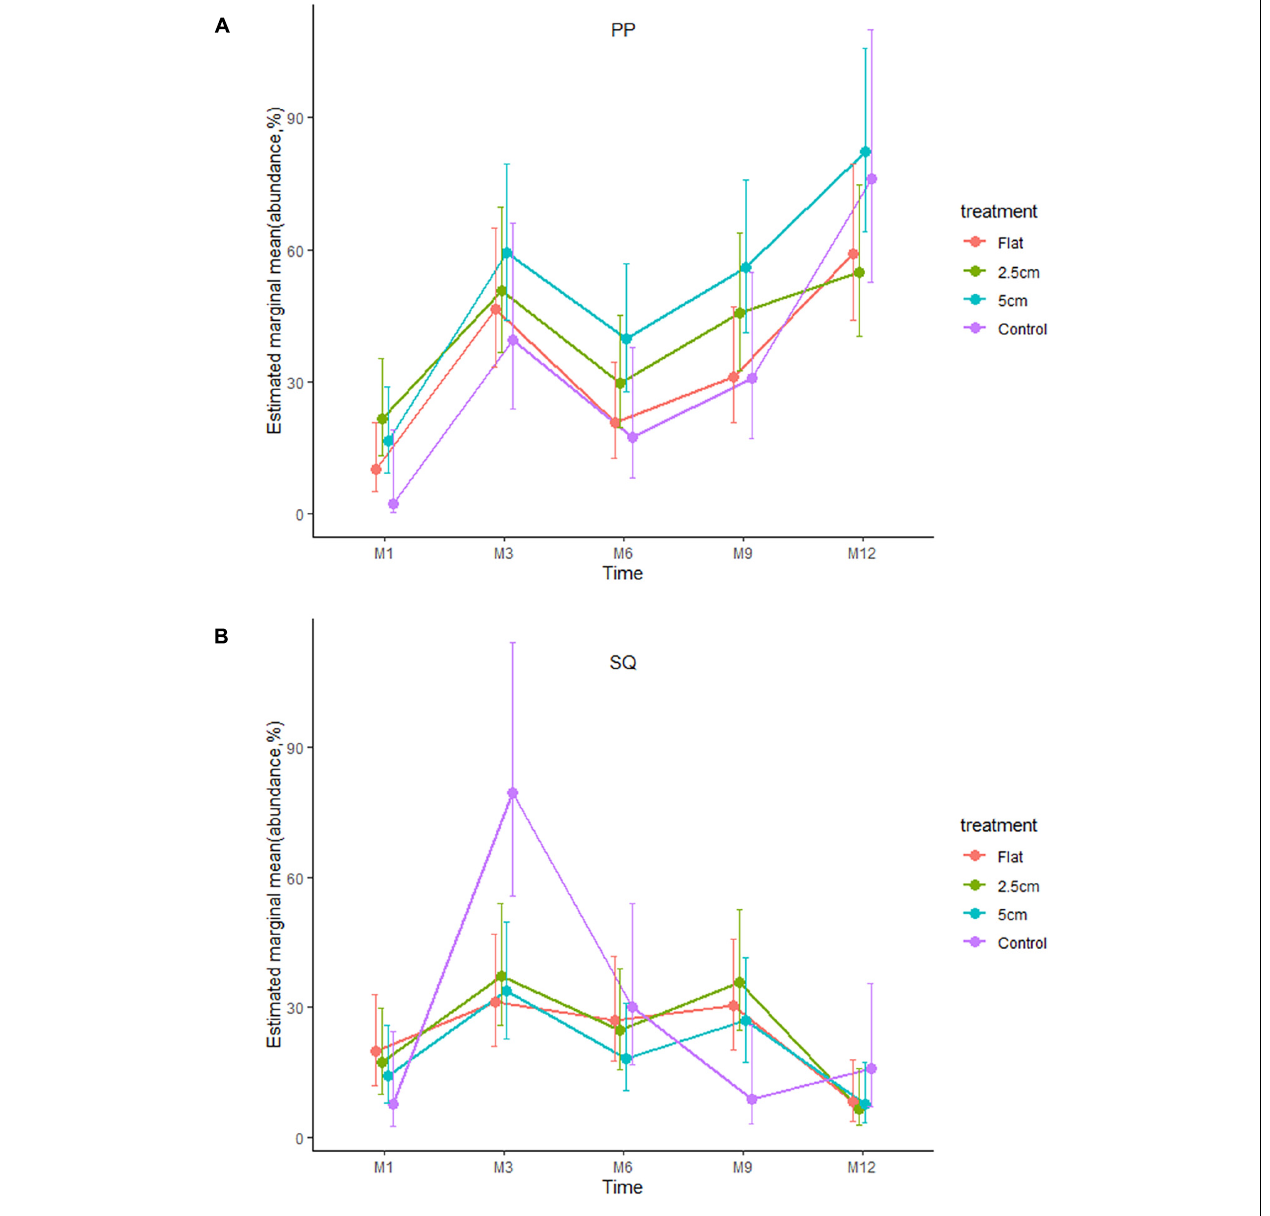
FIGURE 6 | Effects of physical complexity (pooled over unseeded and seeded treatments) on the mean abundances (total percentage of live cover) of the recruited sessile organisms at two study sites: (A) PP: Penang Port and (B) SQ: Straits Quay Marina, Penang Malaysia, at each time